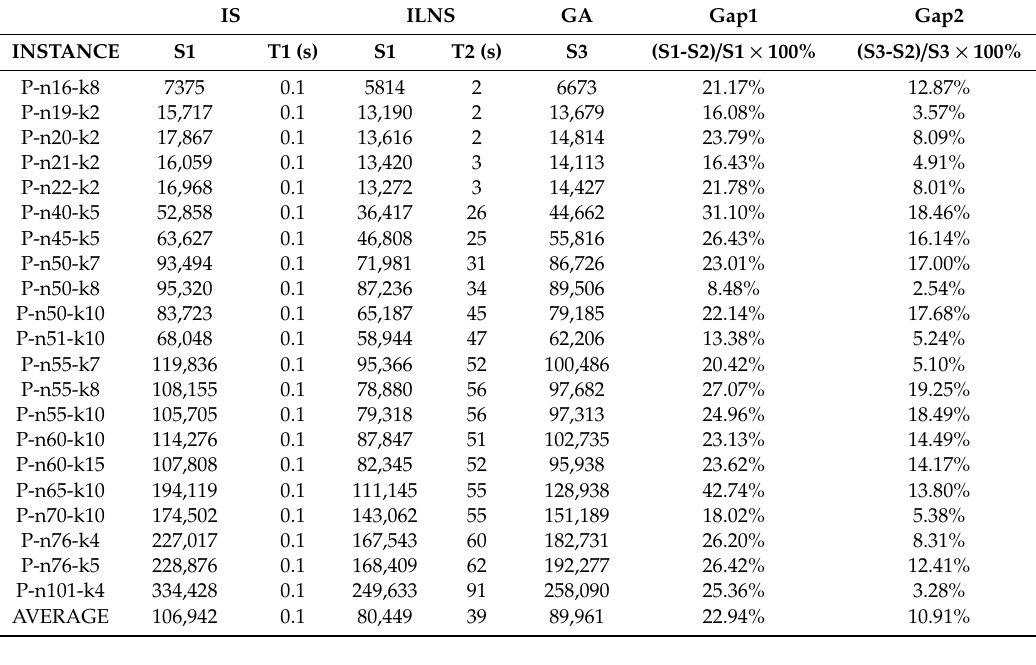
Table 4. Computational results of four algorithms for Group C.